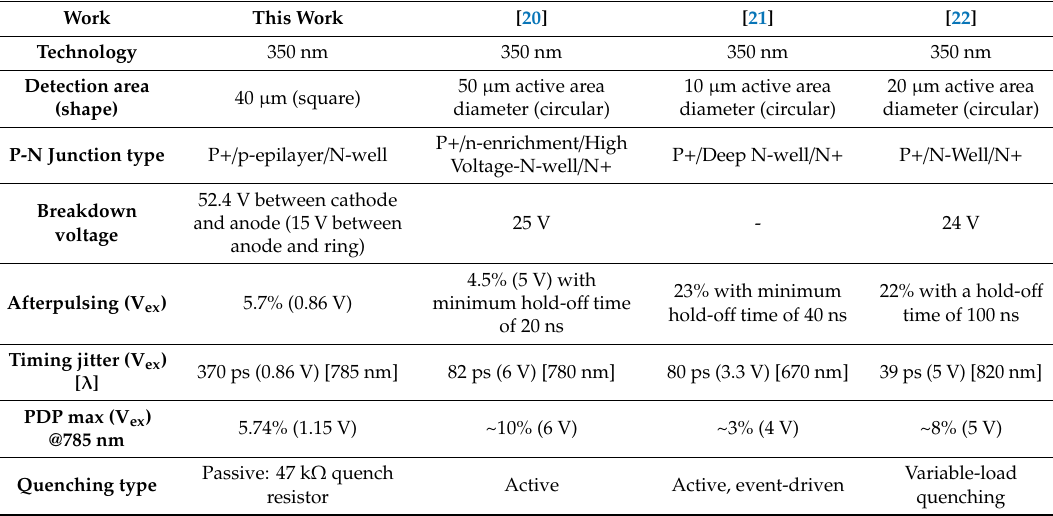
Table 1. Performance parameters of the first generation of CASPAD compared with a few SPADs fabricated in 350 nm CMOS